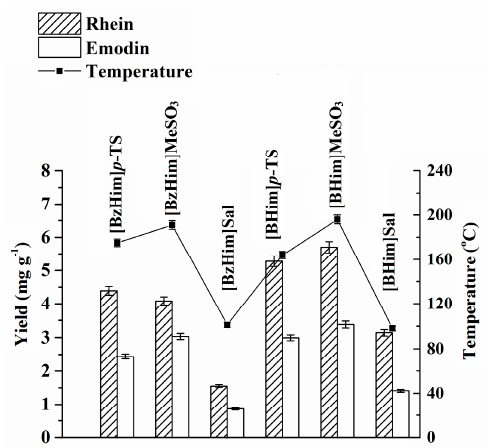
Figure 1. Extraction ability of different protic ionic liquids (PILs). Liquid–solid ratio, 20 g·g − 1 ; microwave irradiation power, 280 W; microwave irradiation time, 70 s; C IL = 80%.